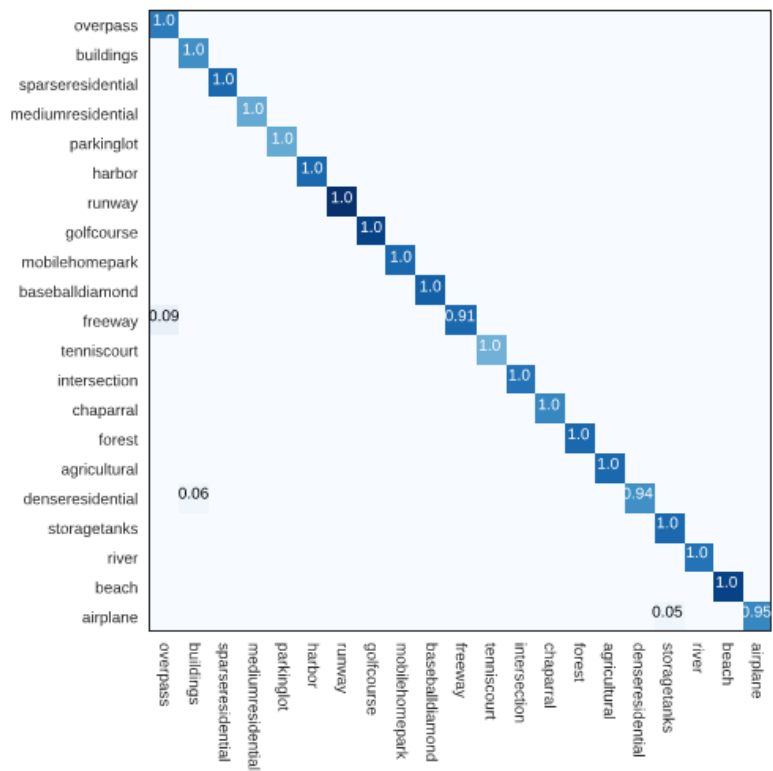
Figure 6. Confusion matrices of the UC Merced dataset under the training ratio of 80% using Deep Discriminative Representation Learning with Attention Map (DDRL-AM). The results in Figure 6 correspond to results shown in Table 2.